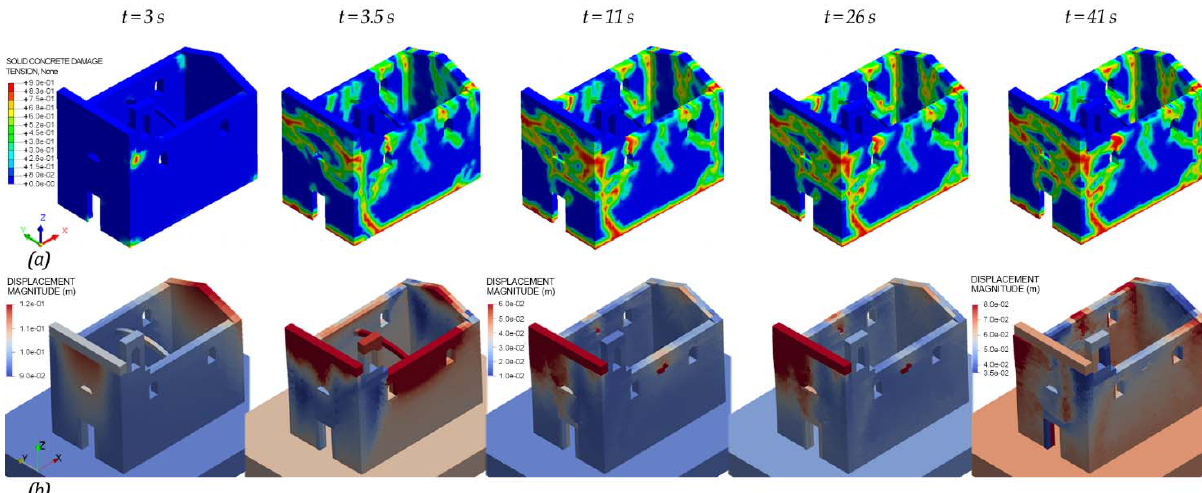
Figure 12. Views of the evolution of ( a ) tensile damage in the CDP model and ( b ) displacement in the NSCD method at different time instants of the nonlinear dynamic analyses performed under the seismic actions near the church.